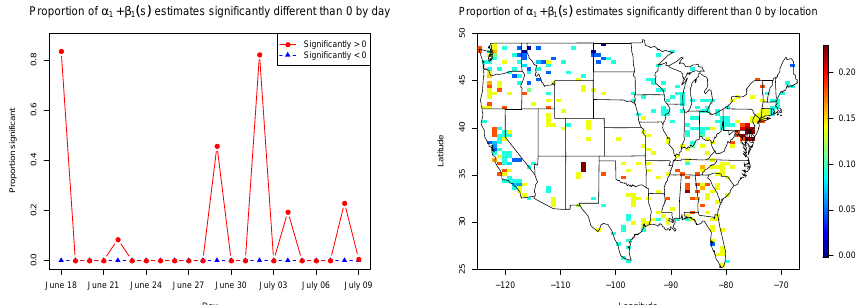
Figure 11. The proportion of α 1 + β 1 ( s ) estimates by day (left) and across space (right) that are significantly different than 0, i.e., 90% credible interval does not include 0, under Eq. (2).